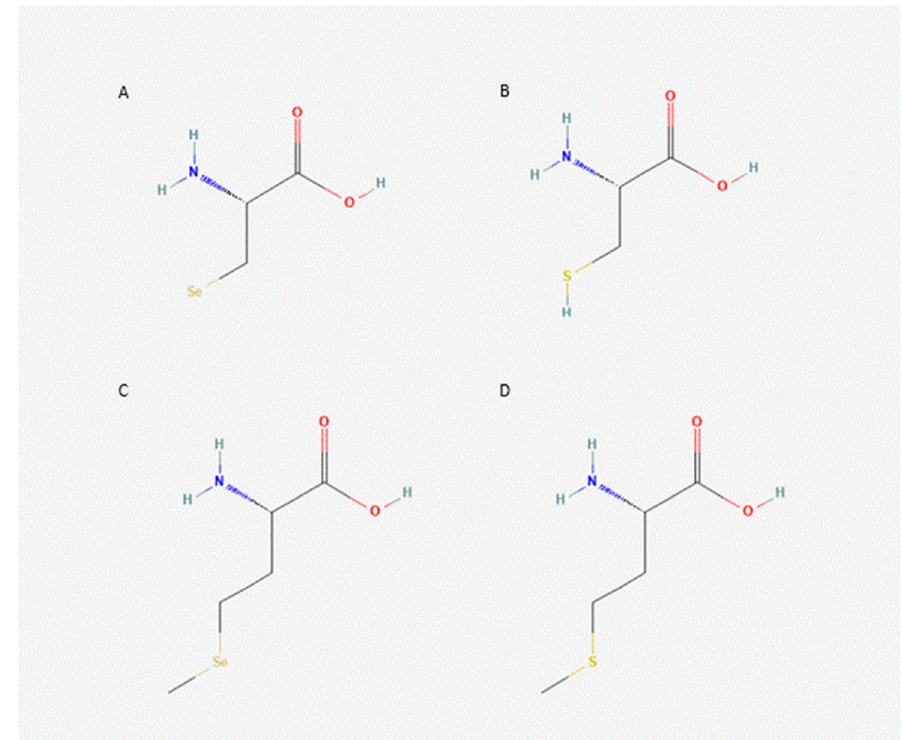
Figure 2. Structures of natural selenoamino acids, selenocysteine ( A , SeCys; CID 6326983) and selenomethionine ( C , SeMet; CID 105024), and their sulfur homologues, cysteine ( B , Cys; CID 5862) and methionine ( D , Met; CID 6137). Structures obtained from Pubchem National Center for Biotechnology Information (2023), https://pubchem.ncbi.nlm.nih.gov, accessed on 7 February 2023.